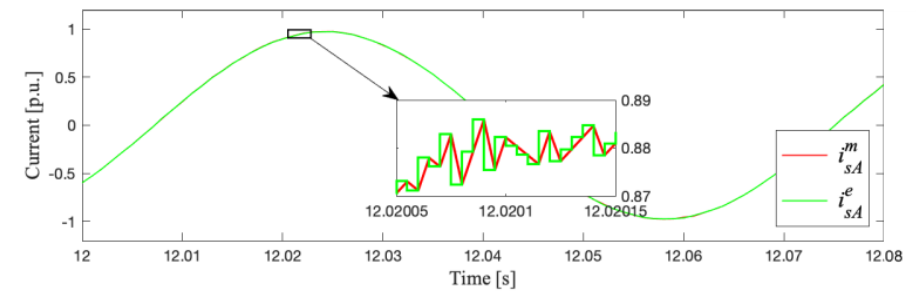
Figure 3. Transient of the measured and estimated current in phase A (simulation tests).